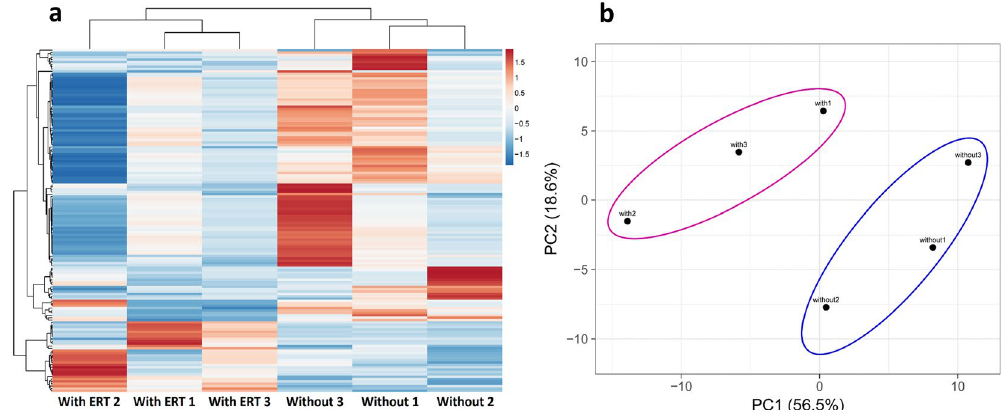
Figure 2. The overall expression pattern of regulated miRNAs. ( a ) Heatmap illustrates the differentially expressed miRNAs in serums of Fabry patients with and without ERT. Rows (expression level of miRNAs) and columns (serum samples) are clustered using correlation distance and average linkage. ( b ) PCA plot of the miRNA expression data indicates the distance between serum samples. X and Y axis show principal component 1 and principal component 2 that explain 56.5% and 18.6% of the total variance, respectively. Each dot in the plot represents one of the six samples used for sequencing based screening.